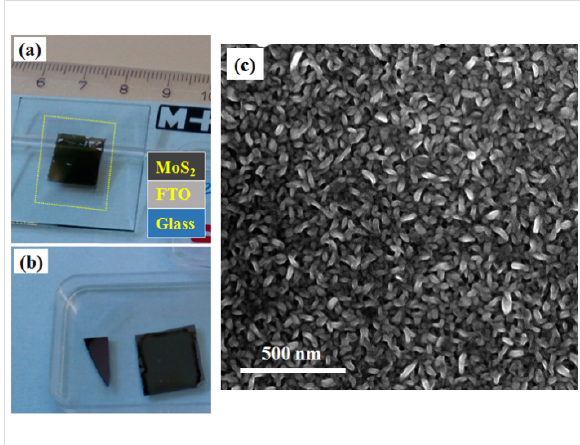
Figure 5: Photographs of (a) wet chemically transferred MoS 2 sample on the FTO/glass substrate, the FTO film on the glass substrate is marked with a yellow dotted square. (b) The remaining square Si sam- ple after being detached from the MoS 2 NSs after the buffered oxide etchant. The triangular sample in panel (b) is a piece from the original sample kept for TEM measurements.